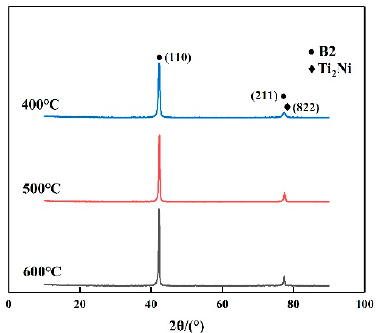
Figure 7. XRD patterns of annealed Ti 50 Ni 47 Fe 3 alloys.